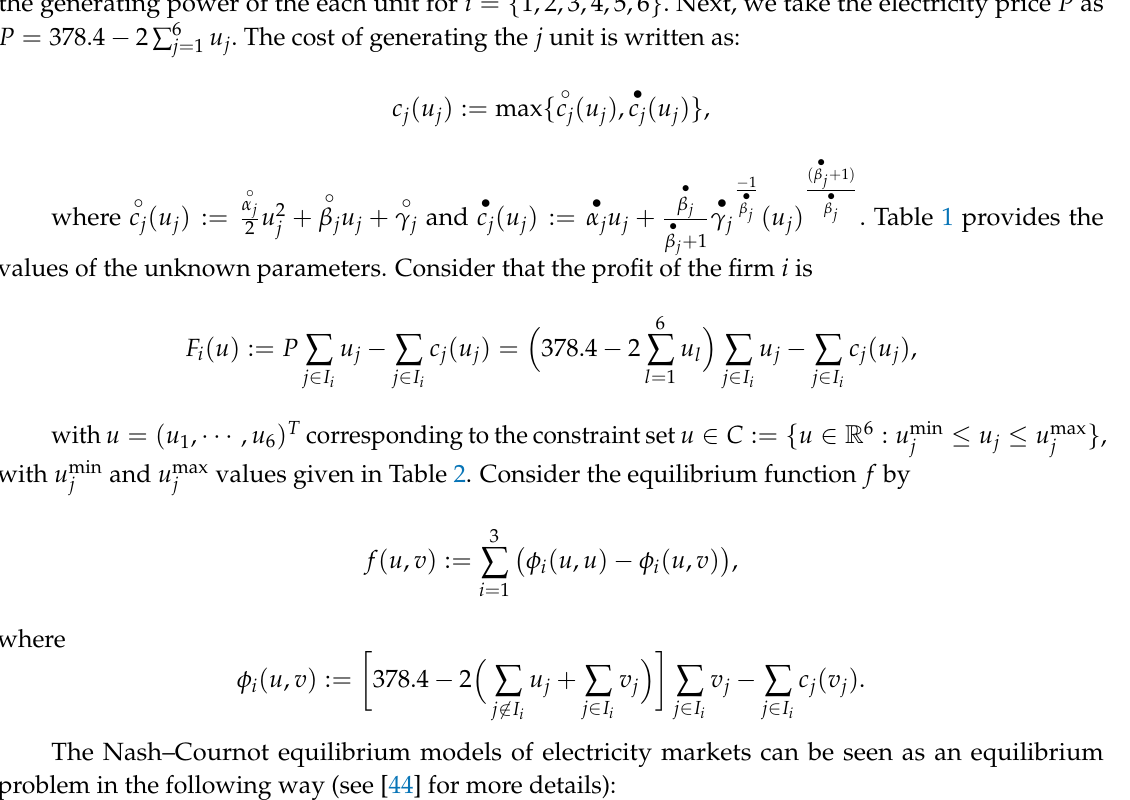
Table 1. The values of parameters are used in the cost function.